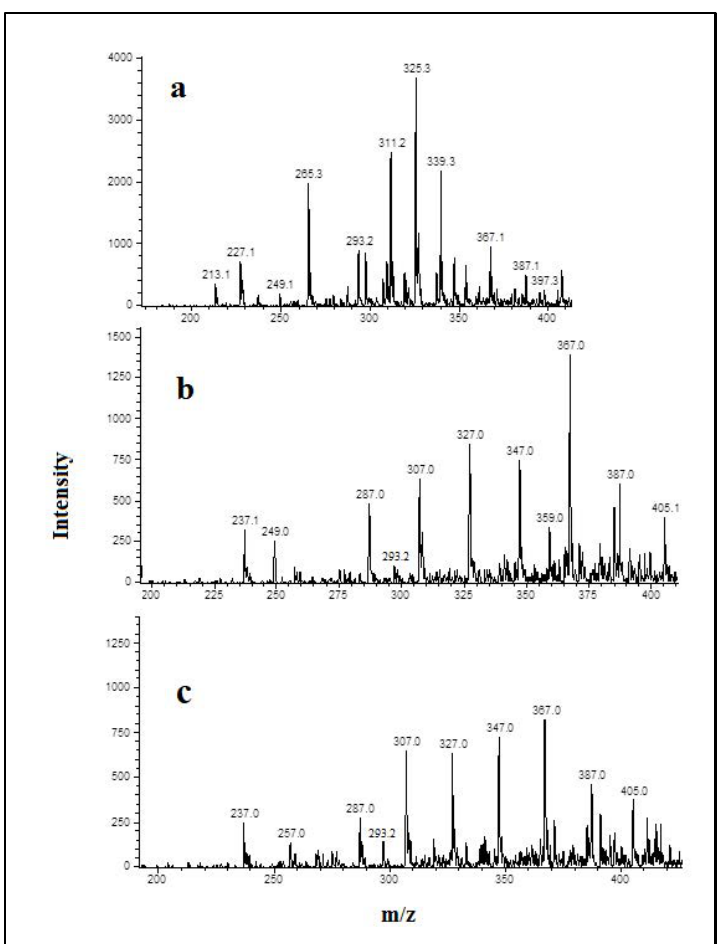
Figure 6. Detection of oxidized polyunsaturated fatty acid from ESI-MS spectra of samples ( a ) F1 T180, ( b ) F2 T180 and ( c ) F3 T180 at m / z range of 250–400 in negative ion mode. In the spectra, it demonstrates characteristic peaks for oxidation of linoleic acid with peak ions m / z 293 and 295, respectively.